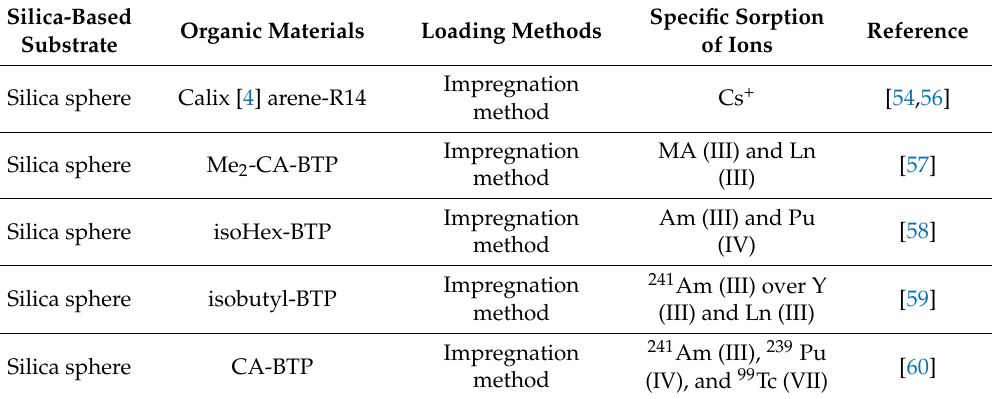
Table 3. The SiO 2 -P adsorbents modified with the specific organic macromolecules, and their applications for treating various